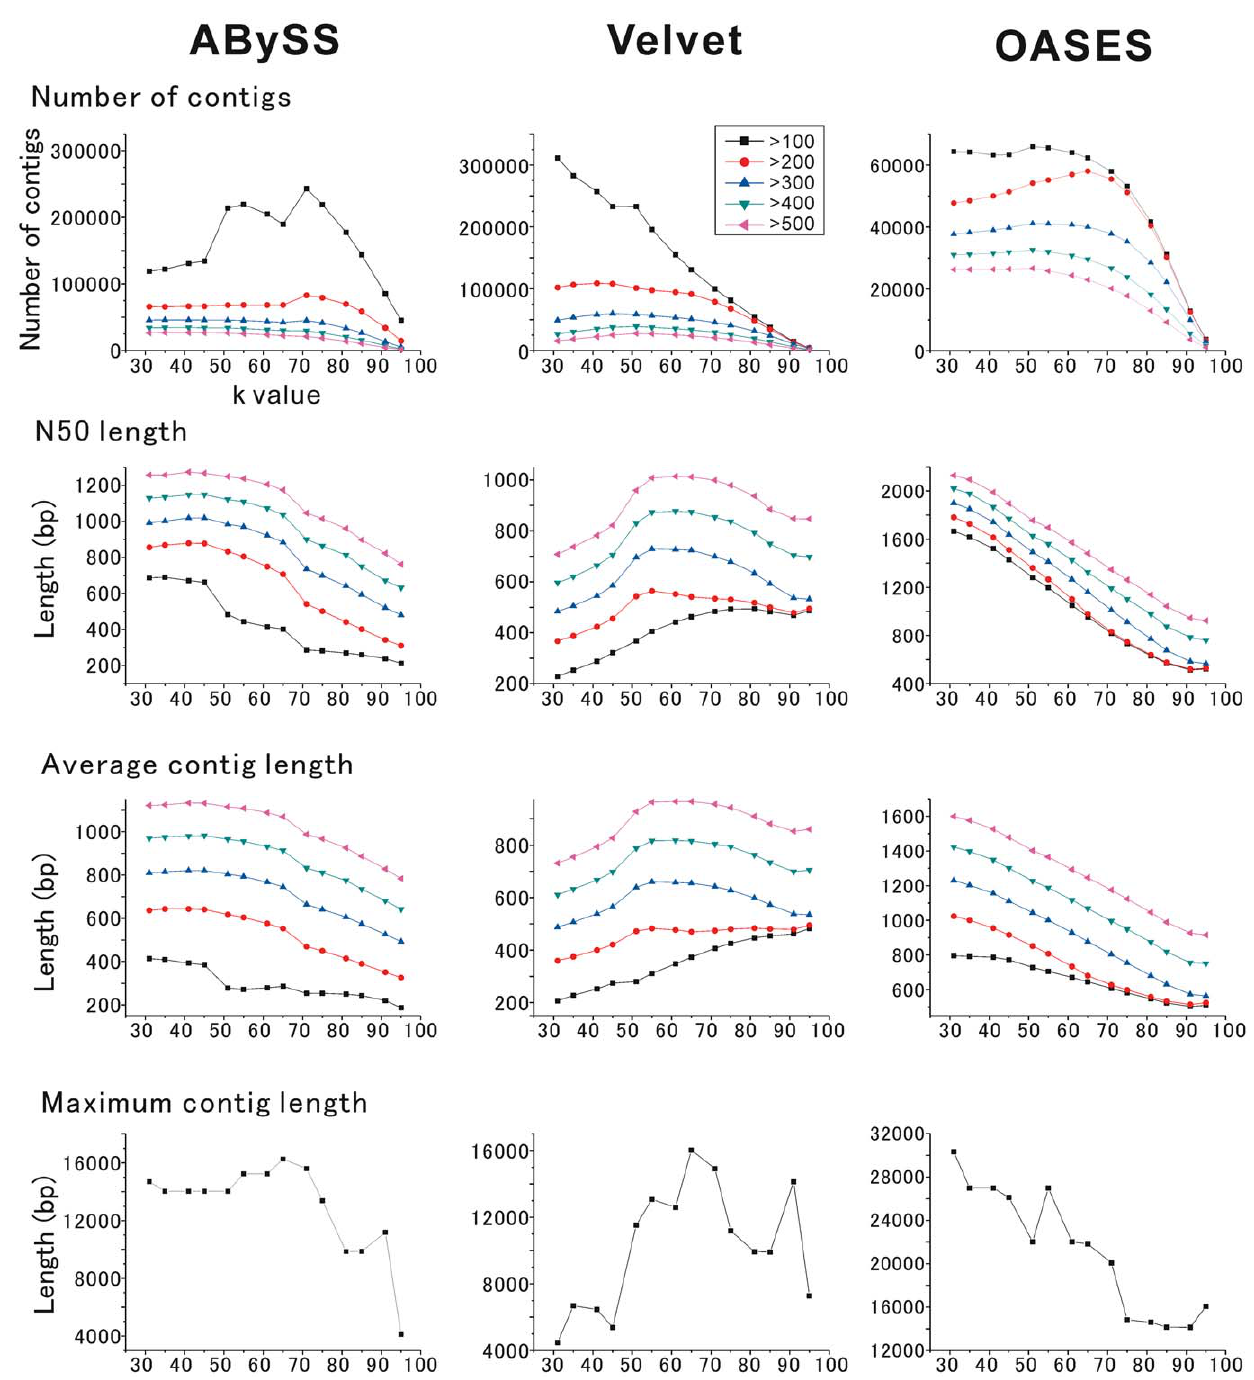
Figure 1. Comparison of denovo assembly with a distinct k-value. Three assembly programs, ABySS, Velvet and OASES, were tested with a distinct k-mer from 31 to 95. In each assembly program, the number of contigs, the N50 length, and the average and maximum contig length were calculated using the assembled contigs longer than 100 bp (black), 200 bp (orange), 300 bp (blue), 400 bp (green) and 500 bp (pink).